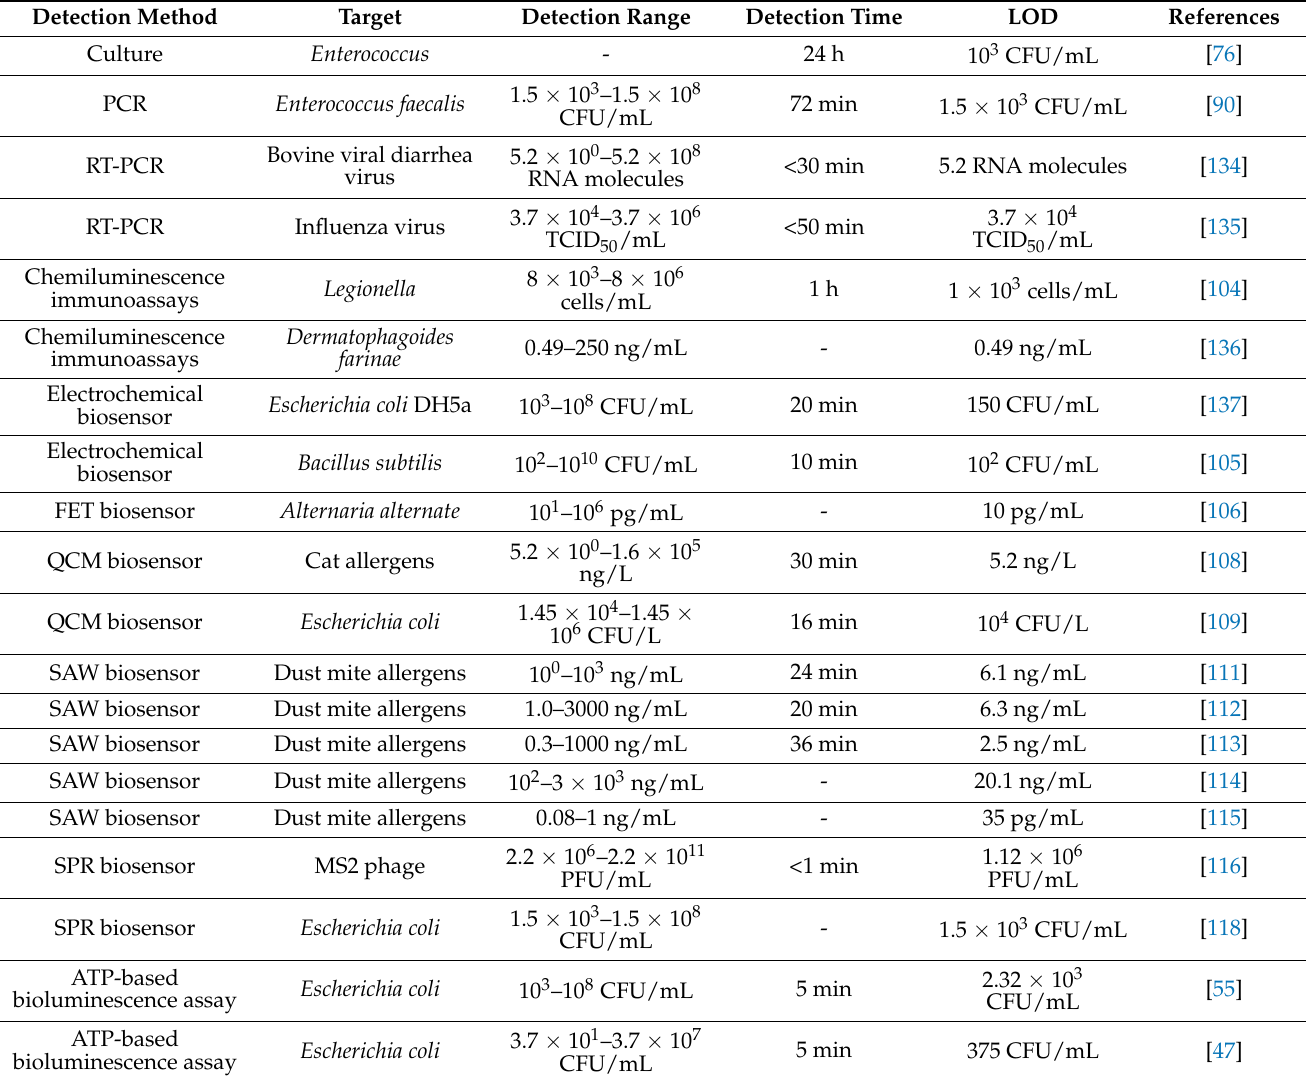
Table 1. Comparison of bioaerosol detection